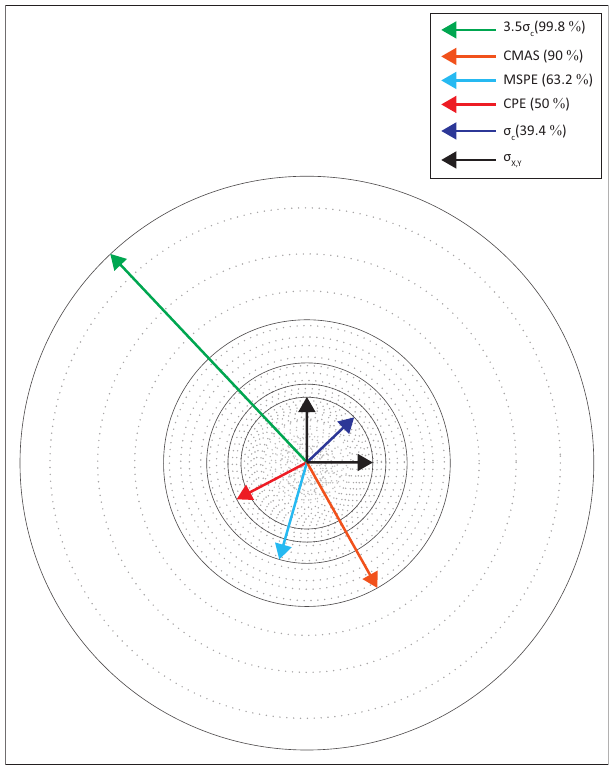
FIGURE 4: Overview of circular error measures; error measures given: three-five sigma error, circular map accuracy standard, mean square positional error, circular probable error, mean circular standard error, directional standard error of X and